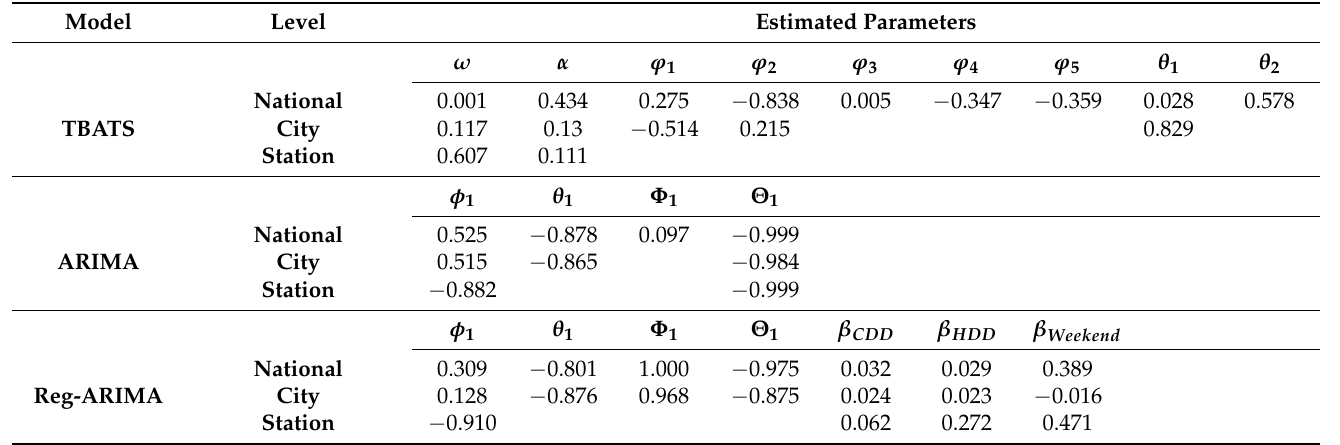
Table 3. Parameter estimations for the classic models at three geographical scales.